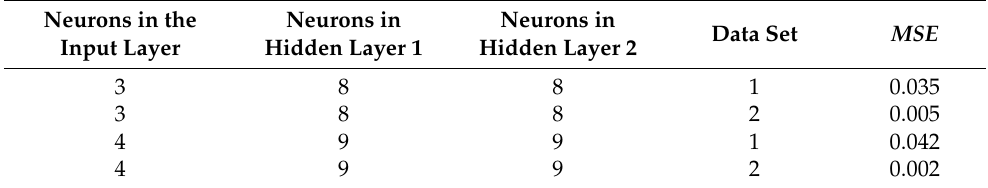
Figure 5. Post training analysis—comparison between experimental data and ANNs developed with three and four inputs.